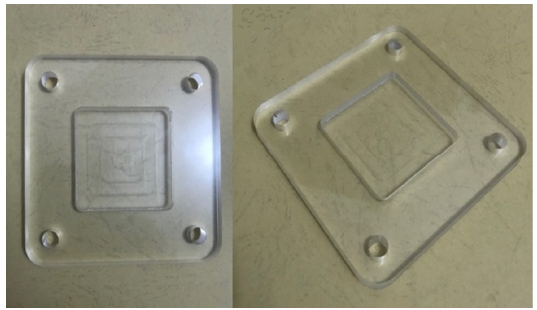
Fig. 7. Application of monitoring messages